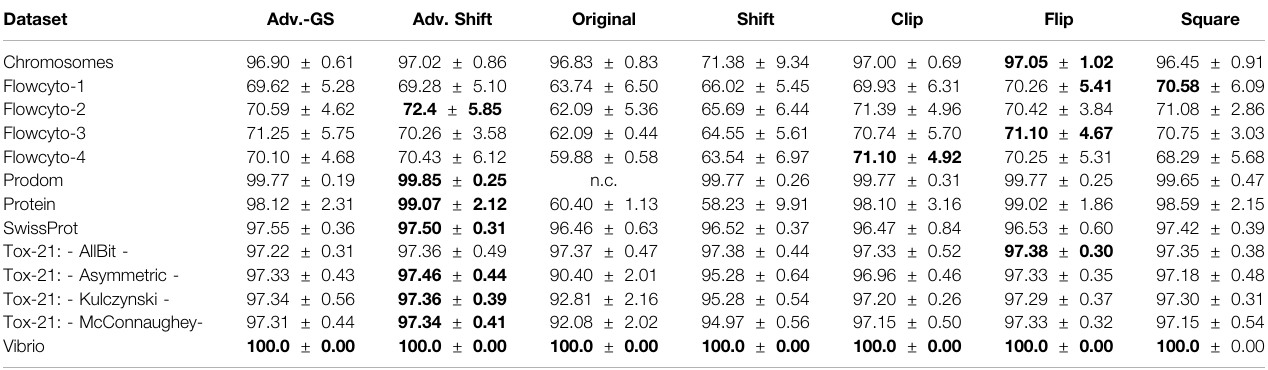
TABLE 3 | Prediction accuracy (mean ± standard-deviation) for the various data sets and methods in comparison to the advanced shift method. Column Adv. Shift shows the performance of the advanced shift method and column Adv.-GS provides the performance of the advanced shift using the Gershgorin approach to estimate the minimum eigenvalue.